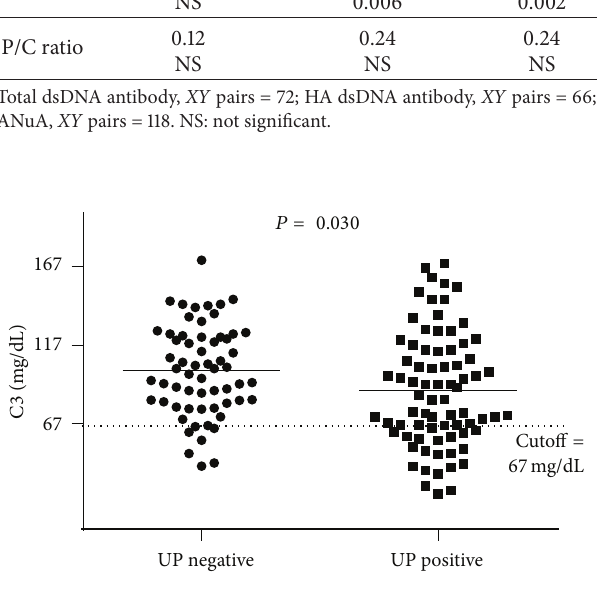
Figure 1: Serum levels of C3 in SLE patients without proteinuria (UP negative, P/C ratio ≤ 0.23) and presenting urine protein (UP positive, P/C ratio >